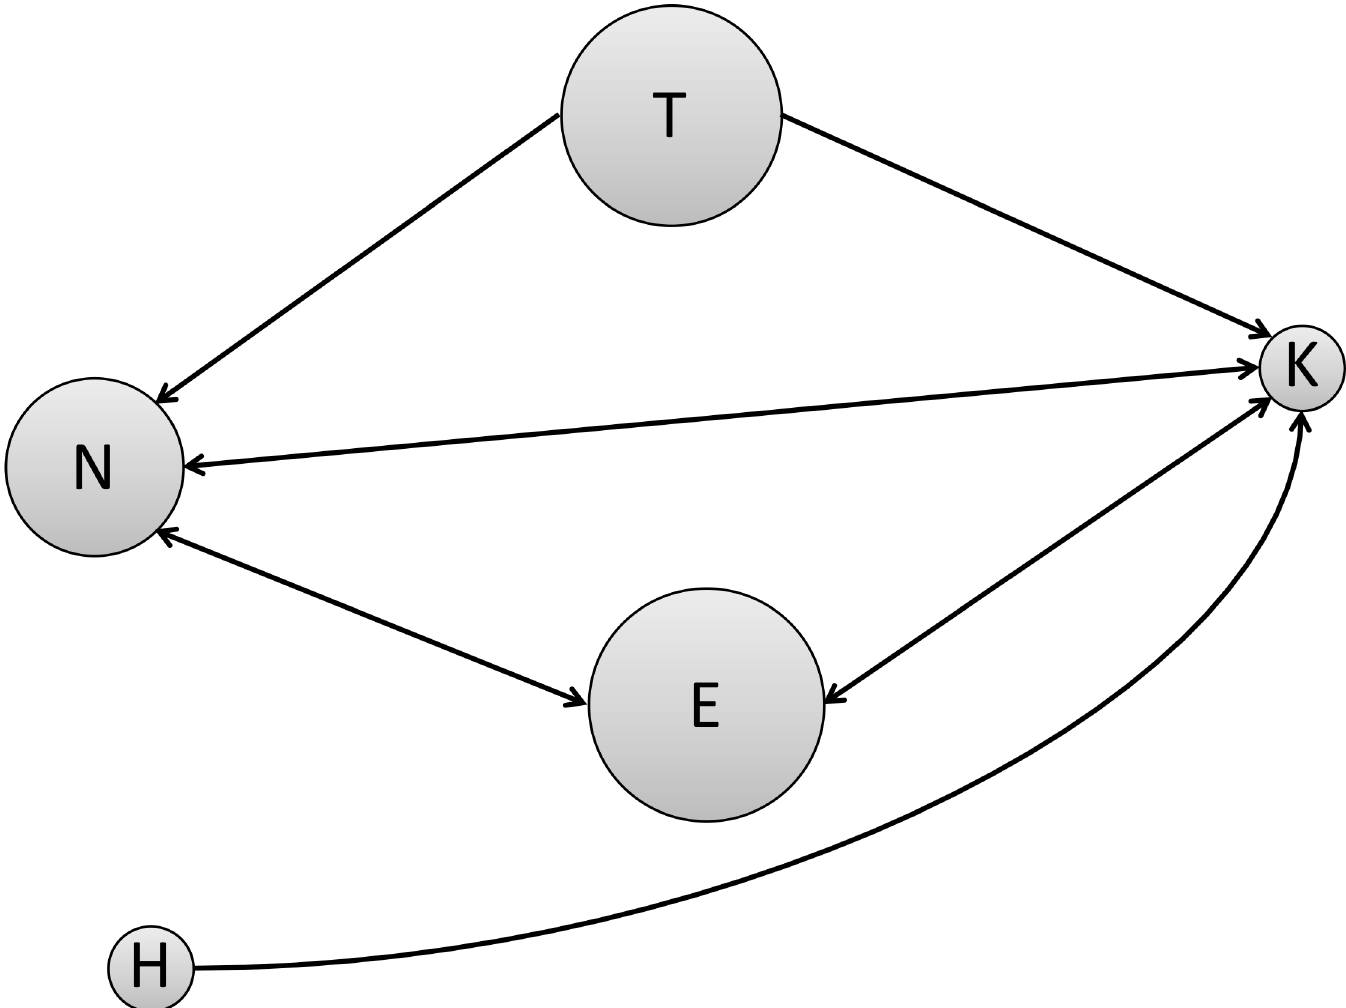
Fig 4. Estimated population size and migrations between populations. Long-term gene flow and population sizes estimated by MIGRATE-N are illustrated. The size of each circle reflects the effective population size of the indicated population. Arrows indicate migration between populations. The direction of the arrows indicates the direction of movement. Migration rates of M > 4 determined by MIGRATE-N are shown. Abbreviations: E, Erimo; H, Hakodate; K, Kitami; N, Nopporo; T, Teshio.